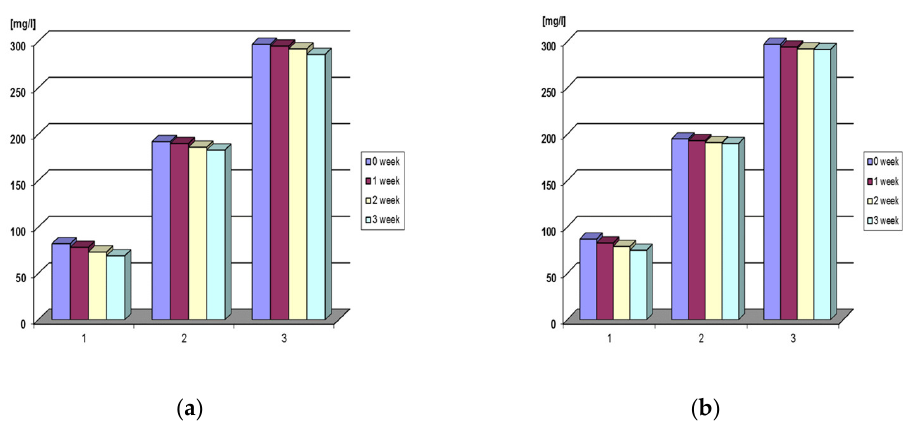
Figure 1. The decrease in chloride ion concentration: (1) 100 mg/L; (2) 200 mg/L; (3) 300 mg/L after 21 days of cultivation by commercial mixture BIOACTIV PH. Table 4. The chloride ion movement during the process of